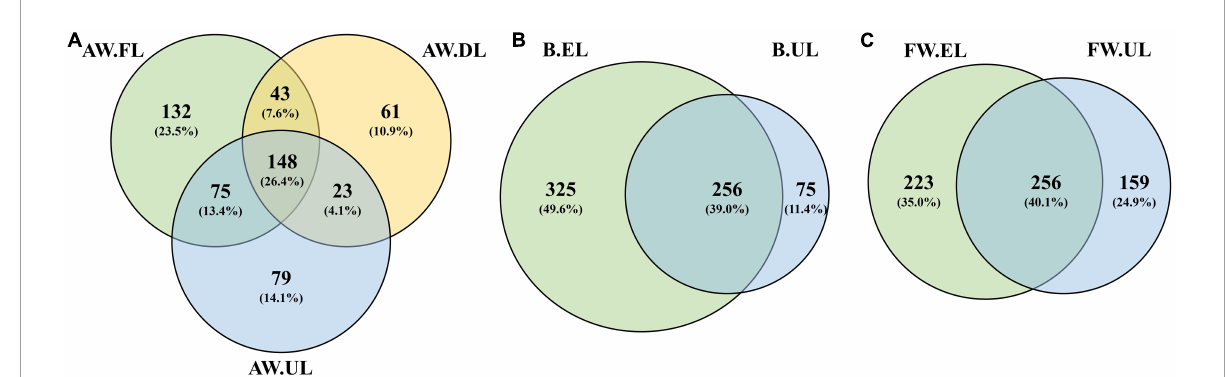
FIGURE4 Venn diagrams representing the number of valid unique OTUs present within samples for each acetification profile. (A) Alcohol wine vinegar; (B) beer vinegar; (C) fine wine vinegar. AW, alcohol wine; B, beer; FW, fine wine; EL, end of loading phase (FL, fast loading; DL, discontinuous loading); UL, just before unloading.